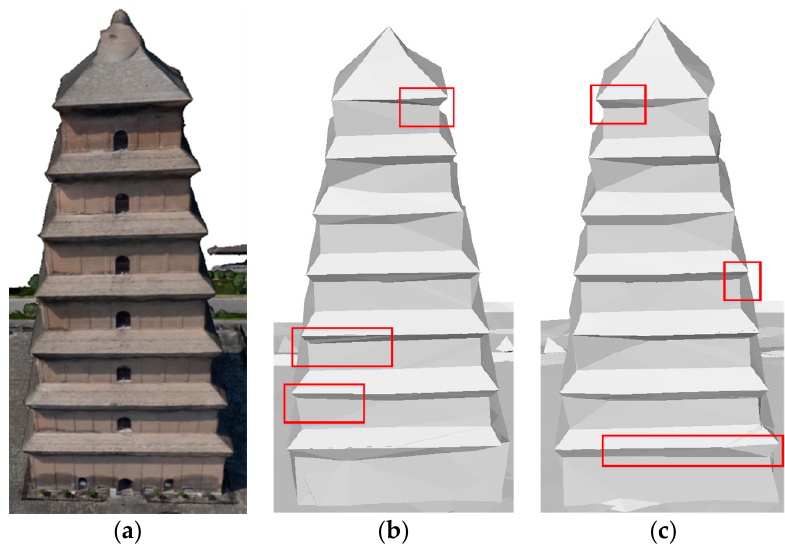
Figure 1. The surface representation of the Greater Wild Goose Pagoda: ( a ) original surface with texture; simplified surface at level 0 simplified by ( b ) aQSlim and ( c ) mDVDC ( λ = 1.8) (all explained in Section 2.3). The parts in the red rectangles perform better, so choosing which one is better is a dilemma.